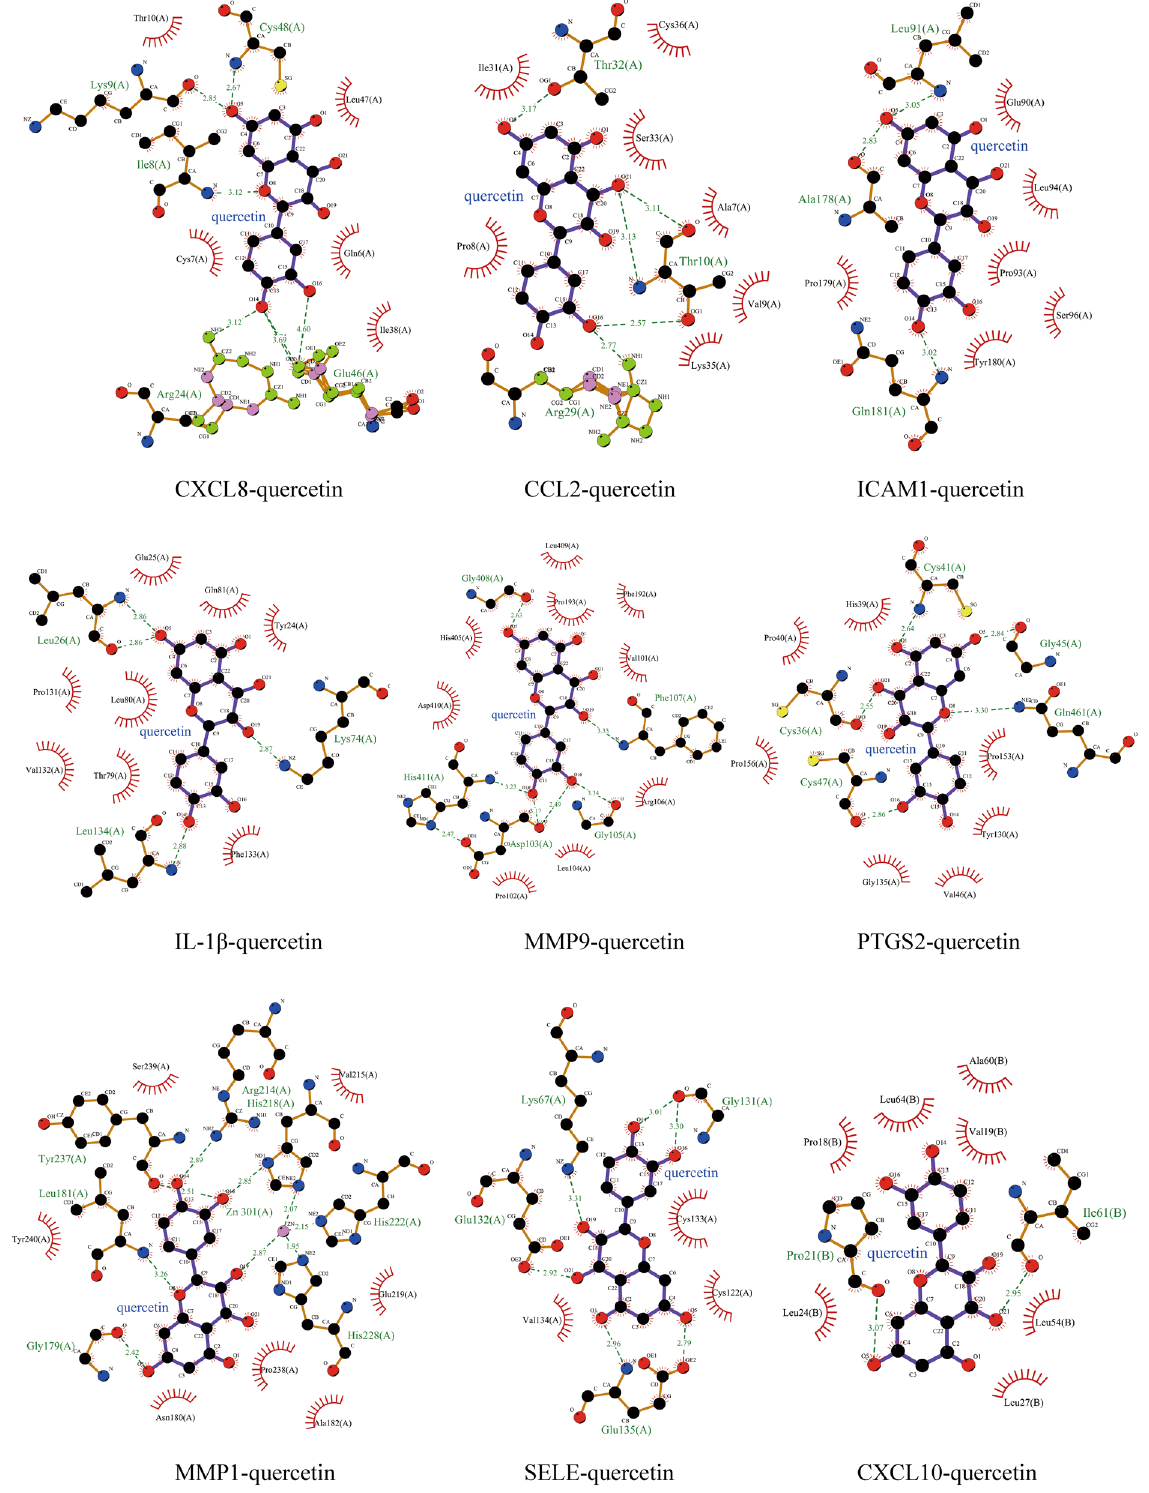
Figure 5. Molecular docking of active ingredients and hub targets. The picture shows the molecular interaction between the protein and the corresponding target, the receptor is highlighted in purple, and the hydrogen bond is shown in green font and the hydrophobic bond is shown in black